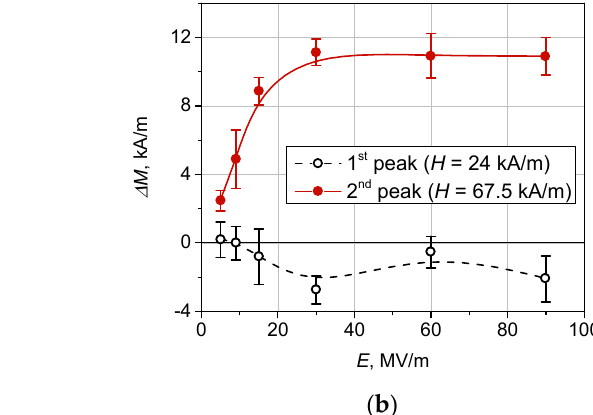
Figure 5. ( a ) Dependence of polarization increment Δ𝑃 on the strength of bias magnetic field strength; ( b ) dependence of magnetization increment Δ𝑀 on the strength of bias electric field.